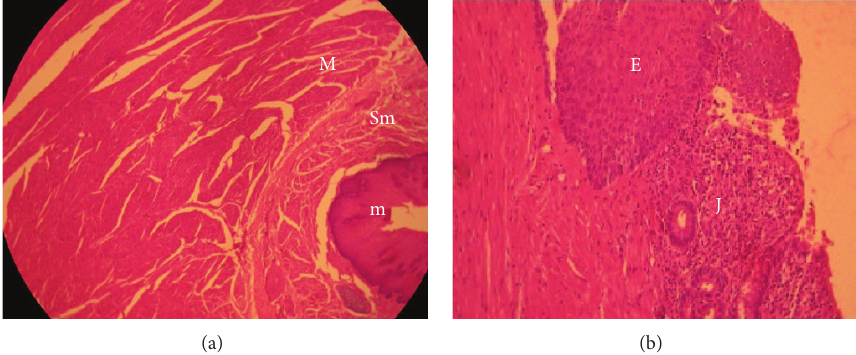
Figure 8: Histopathological findings (H&E × 4) revealing benign distal esophageal stenosis: (a) cross section above anastomotic site (m: mucosa, Sm: submucosa, and M: hypertrophic muscularis propria); (b) esojejunal anastomosis (E: esophageal mucosa, J: jejunal